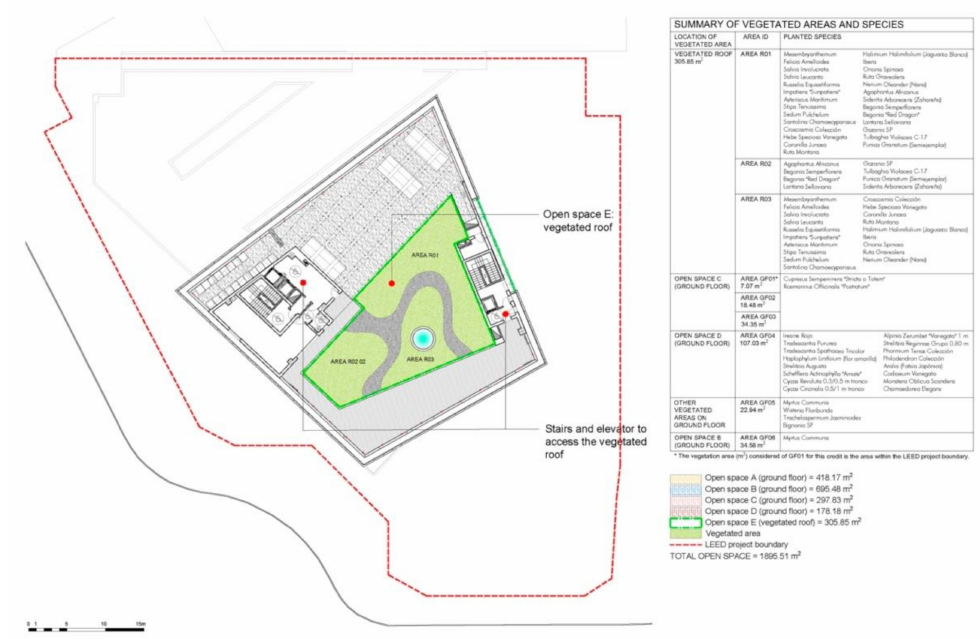
Figure 9. The urban performance boundary of the plot is shown as a red line ( above ). Burbuhuts system of healthy and efficient urban conditioning, in daytime water misting and night-time lighting ( intermediate ) Source: created by the author [64]. Ground floor plan in relation to the outdoor space of the plot. Roof floor with garden area ( below ). Source: Castaño & Associates. LEED Rating System Report